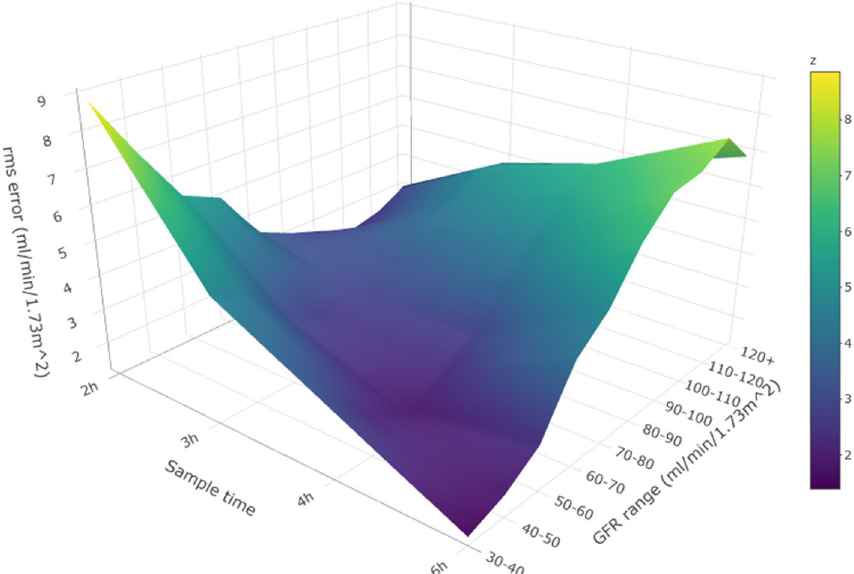
Fig. 2 A 3D surface plot showing the rms error in units of ml/min/1.73m 2 between single-sample GFR and slope–intercept GFR plotted against GFR range and single-sample time. The colours represent increasing rms error from purple to yellow on the colour scale